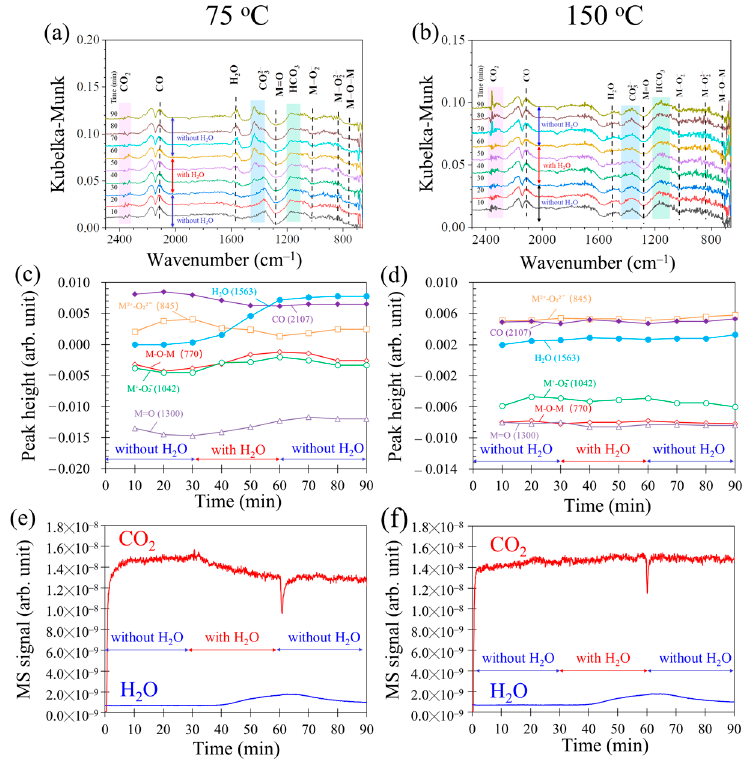
Figure 9. Changes of peak heights of ( a ) M-O-M, ( b ) M=O, and ( c ) M- O (cid:2870)(cid:2879) on each catalyst as functions of temperature.